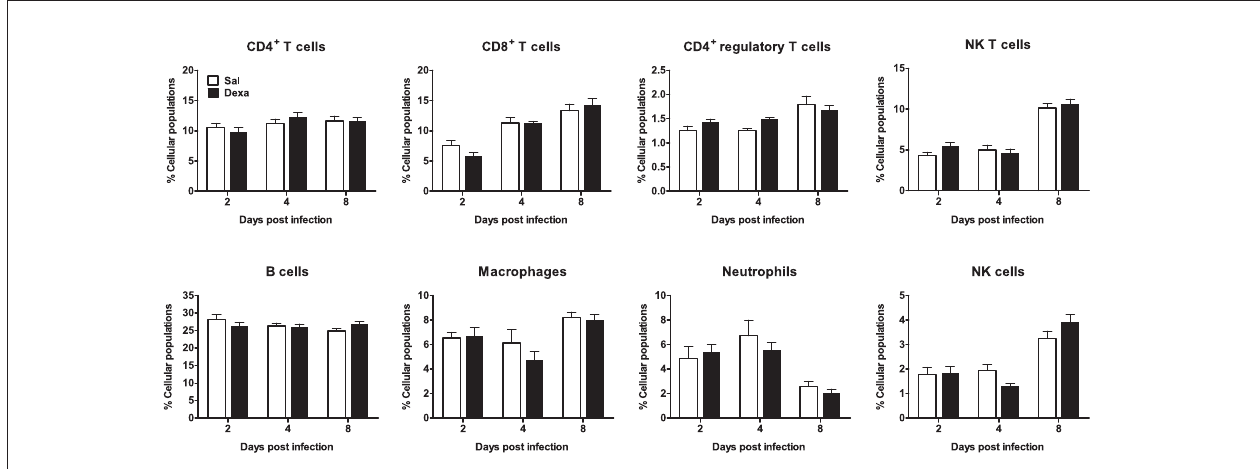
FIgure 6 | Infection with L. monocytogenes results in a similar percentage of spleen cell populations in Sal and Dexa rats. Two, four, and eight days after L. monocytogenes infection, spleen cells from Sal and Dexa groups were stained with specific antibodies and analyzed by flow cytometry. Each bar represents the mean + SEM from six to eight animals per